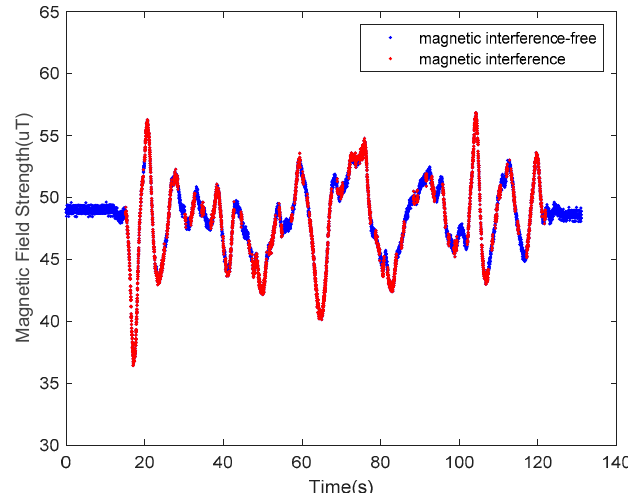
Figure 13. Magnetic data classification results generated by the decisions for indoor pedestrian inertial navigation. The red points are used to mark the interference measurements.